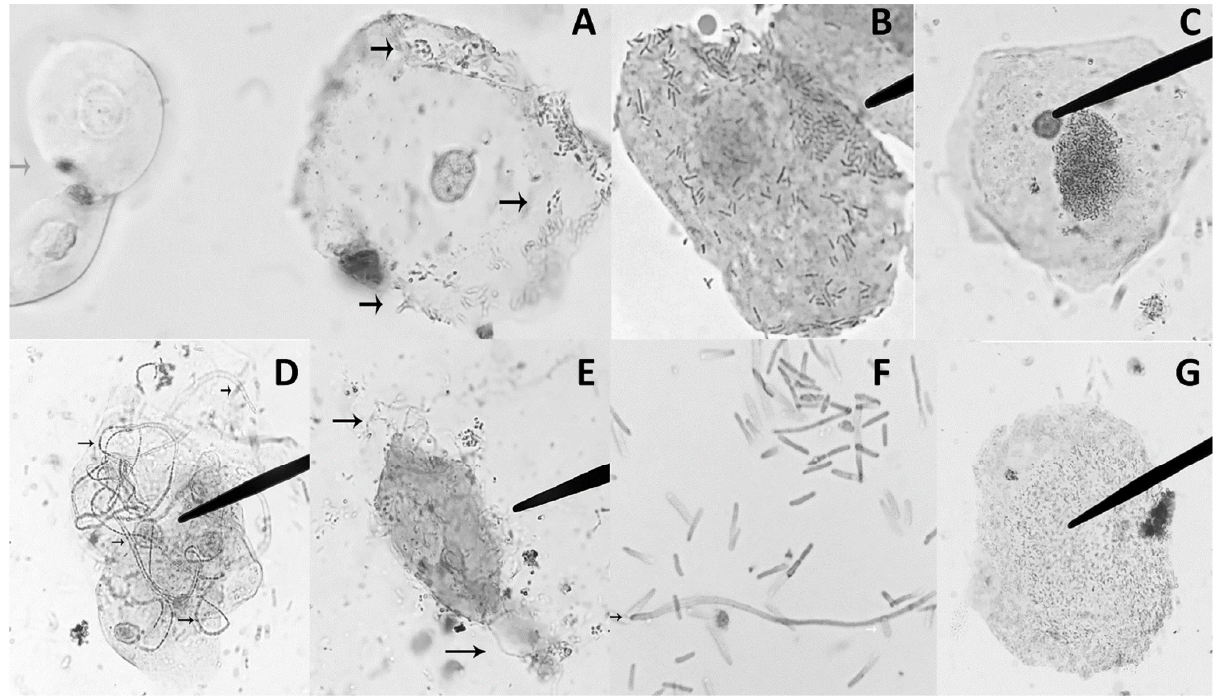
Figure 1. UPEC morphotypes observed in urinary sediment from patients with UTI. Light microscopic images of exfoliated uroepithelial cells and biofilm were stained with Sternheimmer-Malbin dye. ( A ) Right: Vesical epithelial cell with bacterial adherence (black arrows) and left: renal epithelial cell (gray arrow) (40×). ( B ) Vesical epithelial cell with bacterial adherence (100×). ( C ) Vesical epithelial cells and Intracellular bacterial communities (40×). ( D ) Vesical epithelial cells and filamentous E. coli (40×). ( E ) Vesical epithelial cell with cytolysis and filamentous E. coli (black arrows) (40×). ( F ) Filamentous E. coli (black arrow) (100×). ( G ) Biofilm.